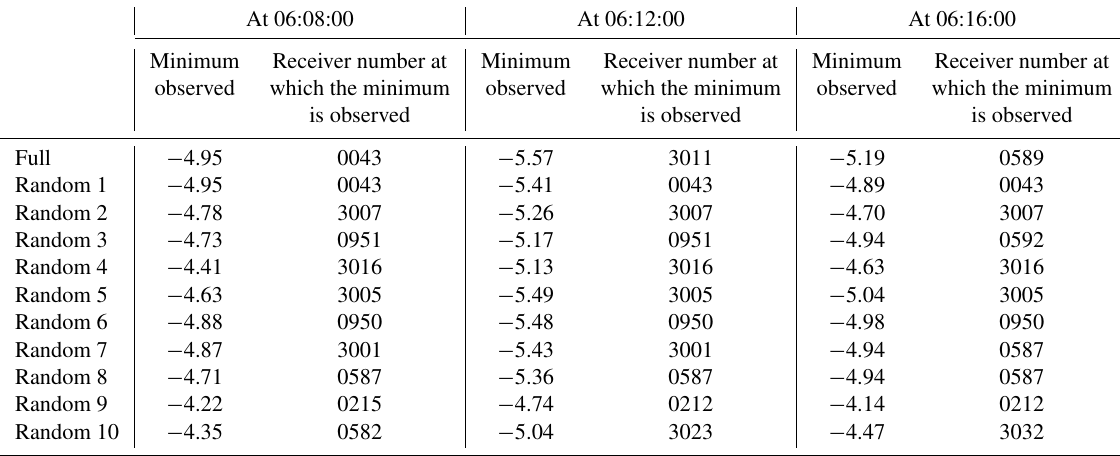
Table 2. Table of the minimum TEC values and the receiver numbers that observed them at three different times. At 06:08:00 At 06:16:00 Minimum Receiver number at Minimum Receiver number at Minimum Receiver number at observed which the minimum observed which the minimum observed which the minimum is observed is observed is observed − 4.95 0043 − 5.57 3011 − 5.19